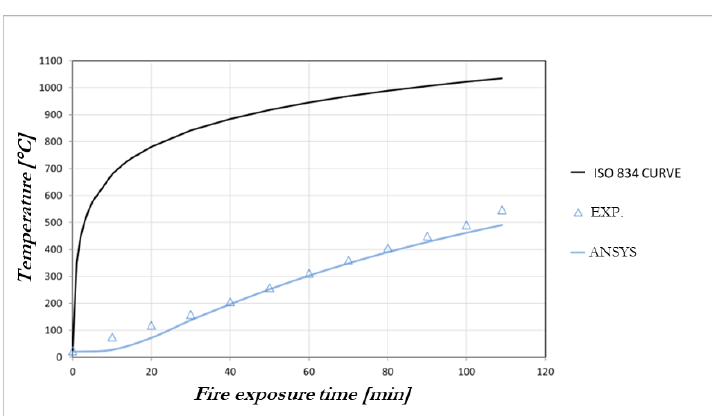
Figure 11. Comparison between experimental (EXP.) and numerical values (ANSYS) of Column 3 temperature evolution at longitudinal steel